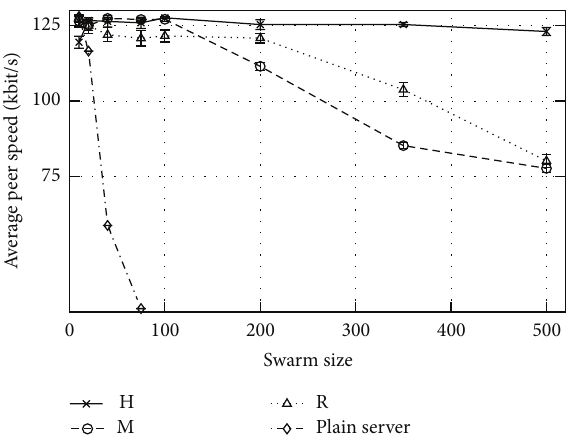
Figure 13: Scenario II: average peer speed depending on a swarm size.